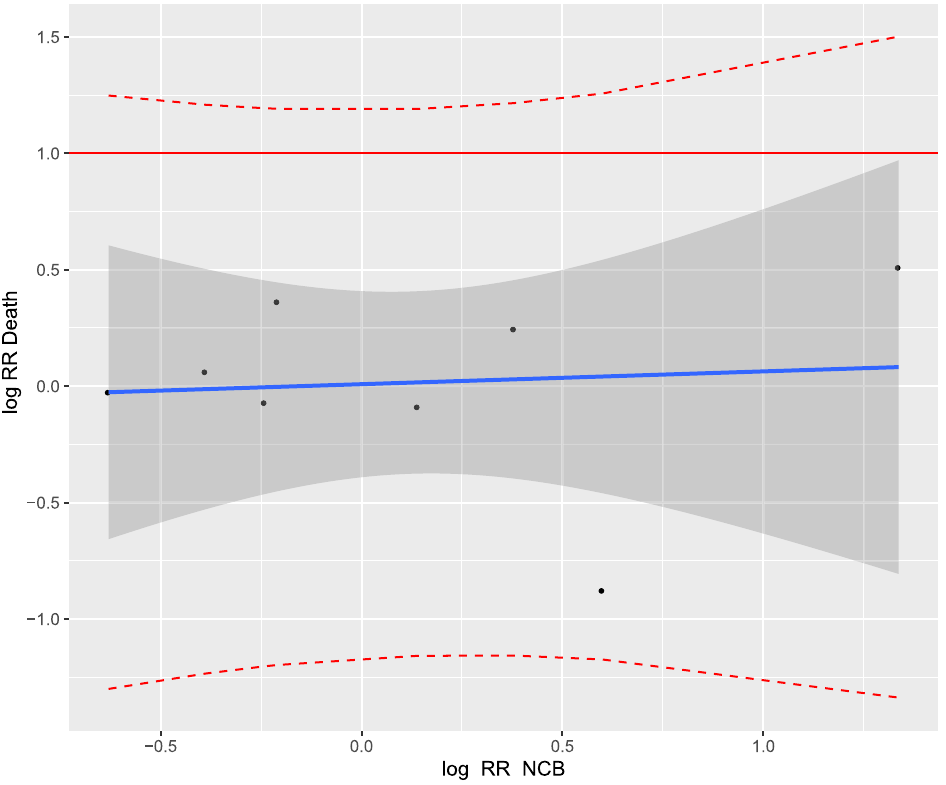
Figure 7. Trial-level association between treatment effects on net clinical benefit (NCB) and all-cause mortality in the treatment of the other prevention in cancer patients. Cor = 0.41 and the linear regression model: "Log RR Death = -0.05 × Log RR NCB + 0.01". Each study is represented by a circle. A log scale was used for the x-axis and y-axis. The solid blue line represents the regression line and the grey area represents the 95% confidence interval. The red dashed lines represent the upper and lower limits of the 95% prediction interval. RR, relative risk.